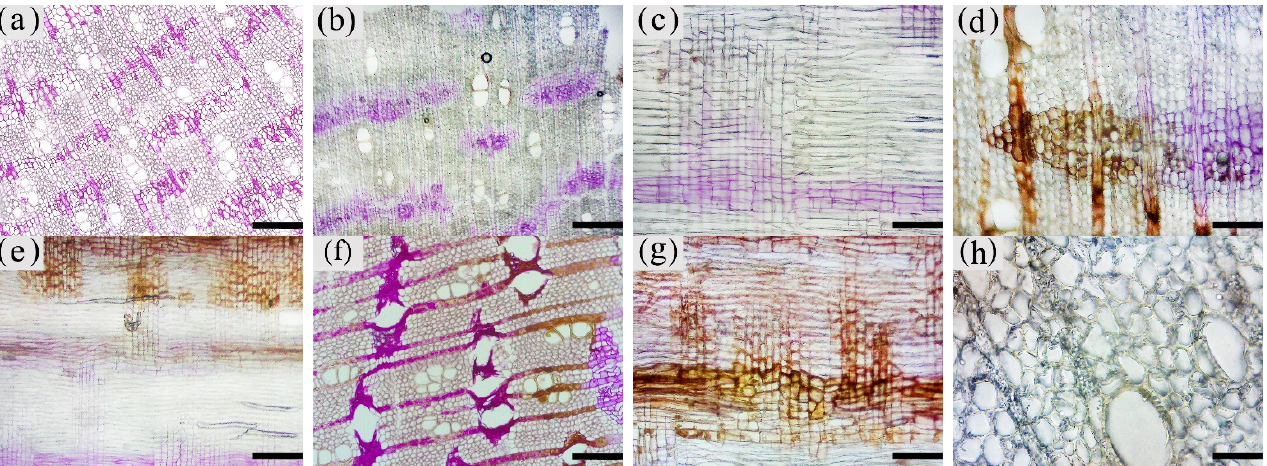
Figure 8. Color development of soluble reducing sugars in xylem parenchyma cells of A. sinensis . ( a ) Transverse surface of blank control. ( b ) Transverse surface of white zone. ( c ) Radial surface of white zone. ( d ) Transverse surface of transition zone. ( e ) Radial surface of transition zone. ( f ) Transverse surface of agarwood zone. ( g ) Radial surface of agarwood zone. ( h ) Transverse surface of decay zone. Scale bars= ( a , b , e , f ) 200 µ m; ( c , d , g ) 100 µ m; ( h ) 50 µ m.